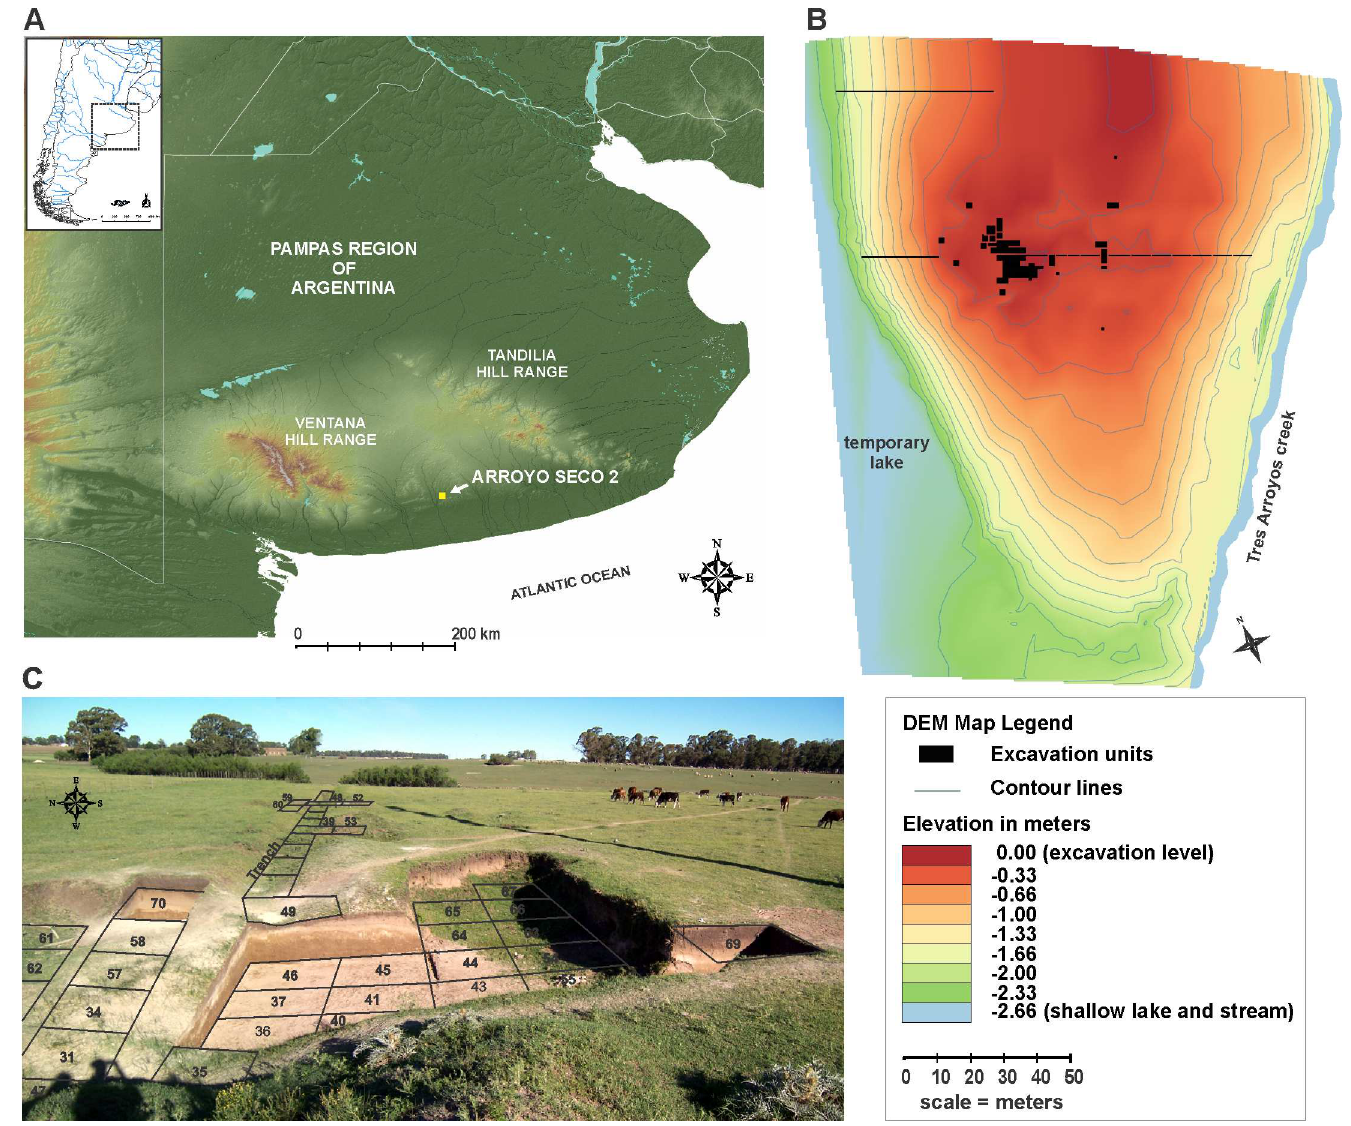
Fig 1. The Arroyo Seco 2 site. (A) Geographic locationof the AS2 site. (B) DigitalElevation Model(DEM)of the knoll and locationof the excavation units (S1 Fig).(C) Photographof central excavation units and